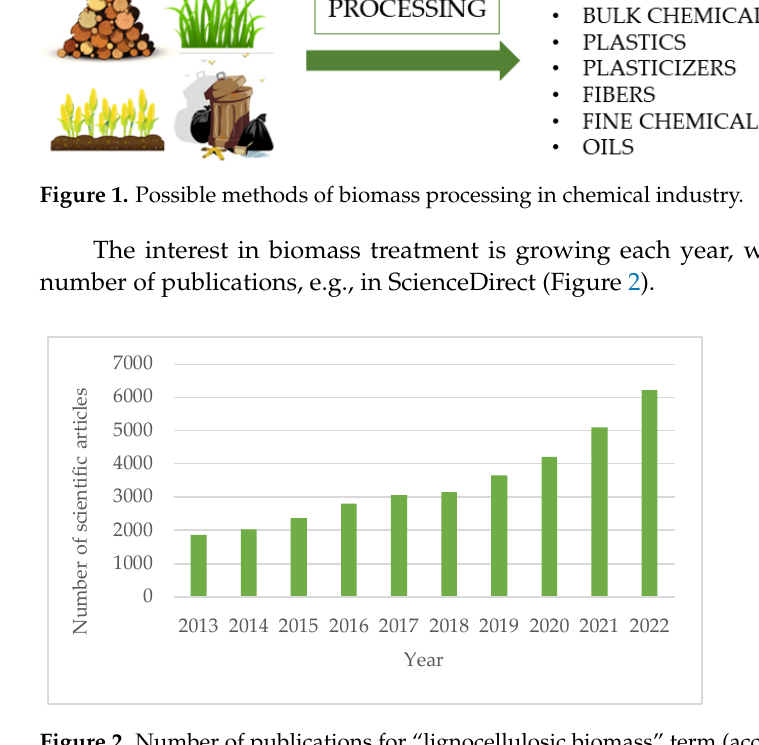
Figure 2. Number of publications for “lignocellulosic biomass” term (according to ScienceDirect).